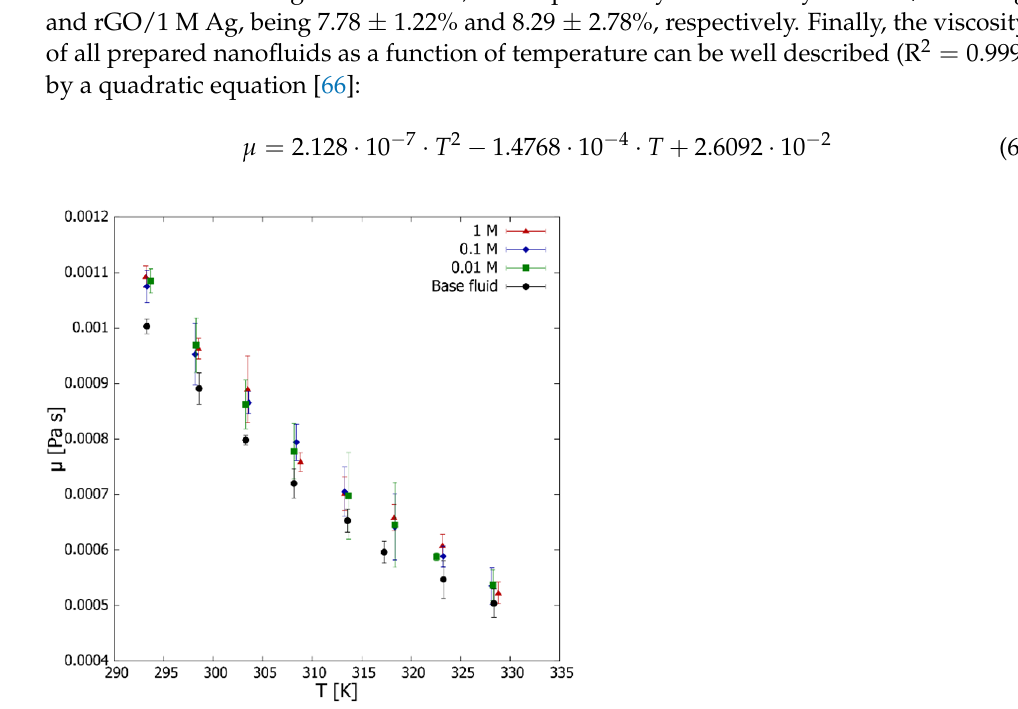
Figure 6. rGO/Ag nanofluid viscosity with respect to the temperature and molar concentration of Ag. The error bars correspond to the measurements’ standard